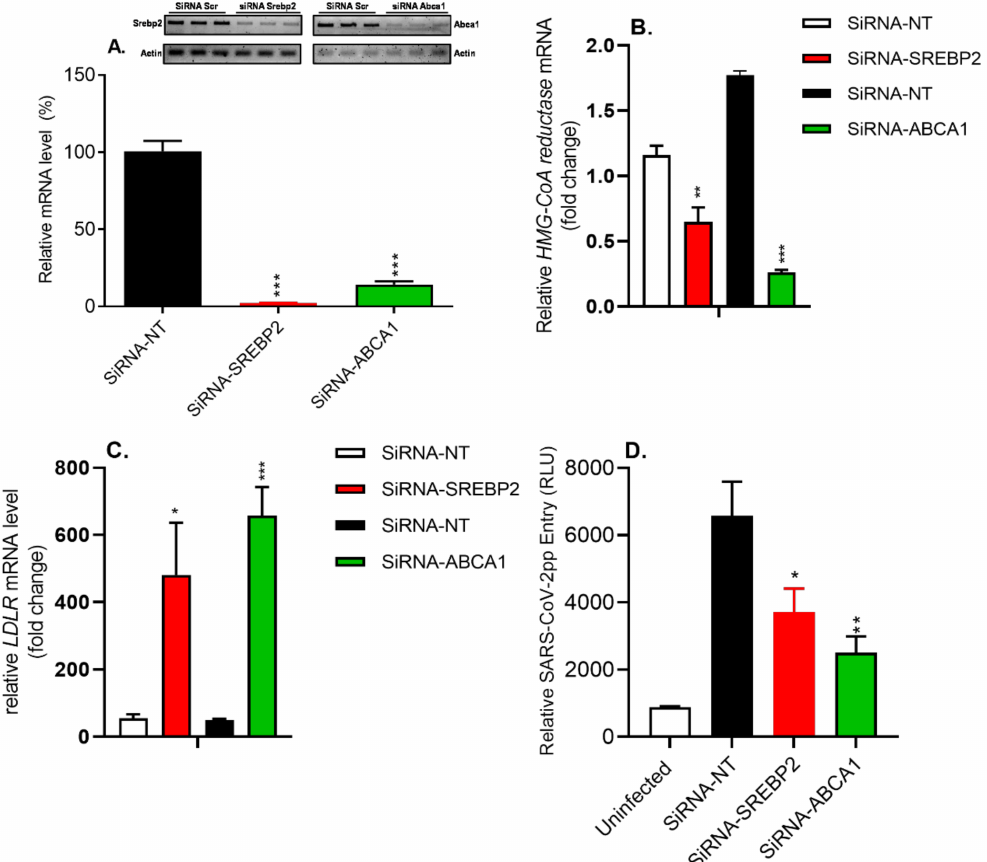
Figure 9. Silencing of the SREBP2 and ABCA1 genes reduces SARS-CoV-2pp entry into cells. Huh7 cells were transfected with siRNA-NT (control) or siRNAs targeting SREBP2 and ABCA1 for 48 h prior to infection with SARS-CoV-2pp for an additional 48 h. The relative quantity of mRNAs for SREBP2 and ABCA1 was determined by qRT-PCR ( A ), and the qPCR products were separated on a 2% agarose gel and visualized (Panel A , top). Additionally, targets genes for the knockdown of SREBP2 and ABCA1 were quantified by qRT-PCR ( B , C ). SARS-CoV-2pp entry was assessed by a luciferase assay ( D ). Values are plotted as the mean ± SD (N = 4). p values were calculated using a two-tailed Student t test. * p < 0.05, ** p < 0.001, and *** p < 0.0001 vs. siRNA-NT group